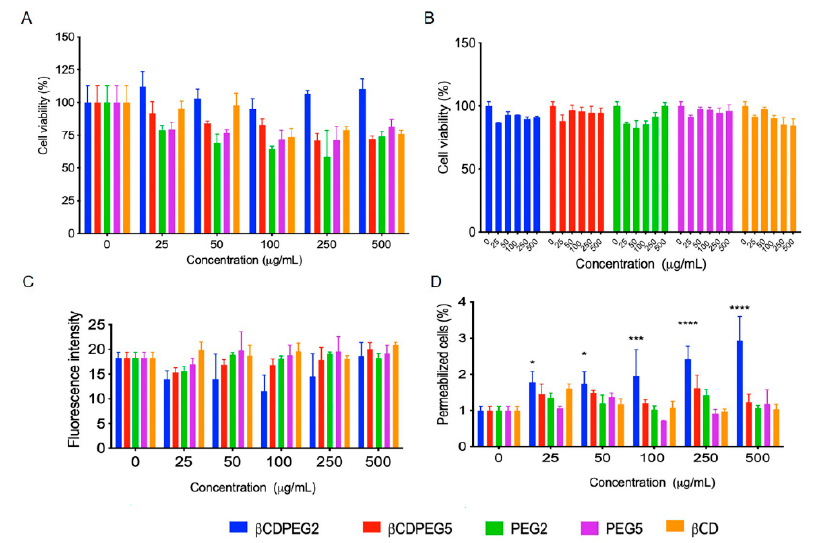
Figure 6. Effects of β CDPEGs, β CD, and PEGs on MDCK cells. ( A ) Cell viability; ( B ) recovery of MDCK cells; ( C ) ROS overproduction; and ( D ) cell membrane permeability. All results are expressed as the mean ± SD ( n = 3) * p < 0.05; *** p < 0.001; **** p < 0.0001 using two-way ANOVA with a Dunnett’s multiple comparison tests.